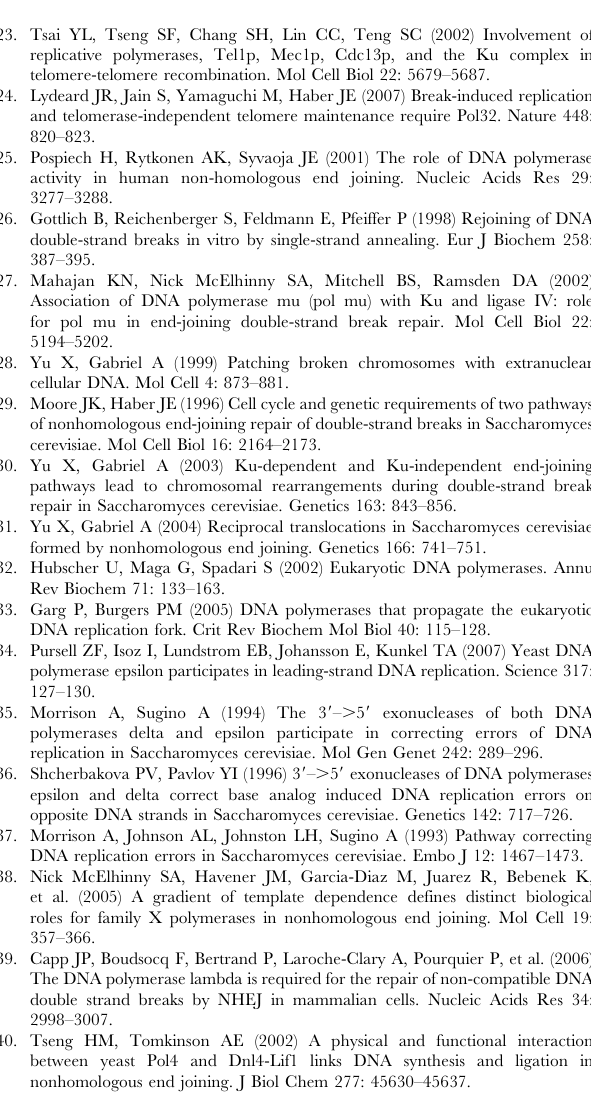
Table S2 Quantitative analysis of repair events at the UR- A3::ACT1 intron::HO cut site locus of essential DNA polymerase